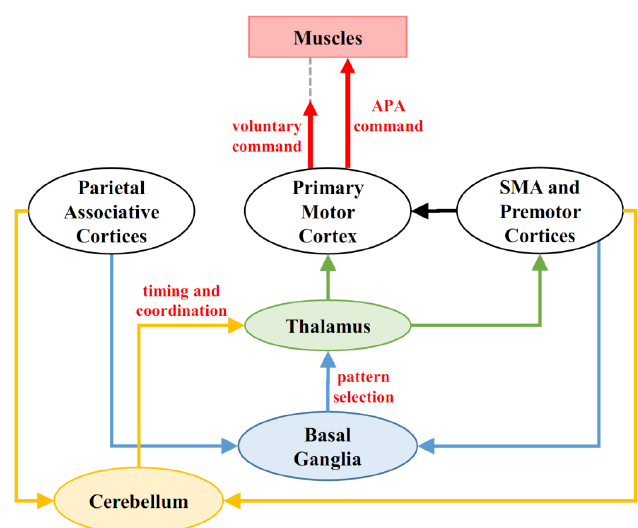
Figure 1. Role of Cerebellum and basal ganglia in APA programming. Cerebellum and basal ganglia receive information about the environmental context and body schema from the Parietal Associative Cortices, as well as about the motor goal from SMA and Premotor Cortices. In turn, basal ganglia define the pattern of muscular recruitment (i.e., the muscles which should be excited or inhibited), while the timing and the coordination of such actions is defined by the cerebellum. Through their Thalamic projections, the final motor program reaches the Primary Motor Cortex, which routes it to both the focal and postural muscles. Note that the APA command reaches the postural muscles before the voluntary command activates the focal